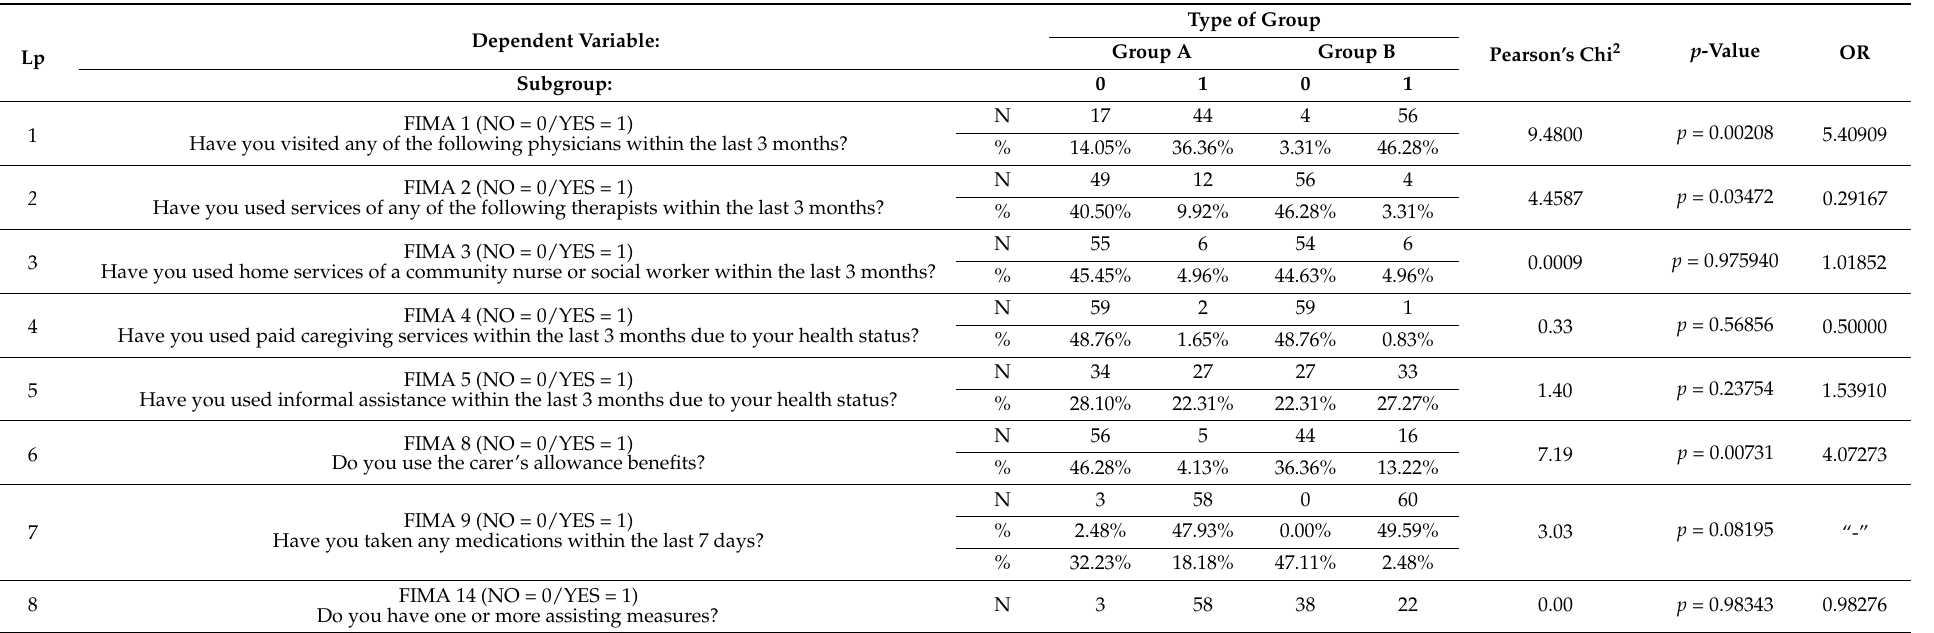
Table 4. Selected FIMA areas concerning the use of medical and non-medical services within the past 3